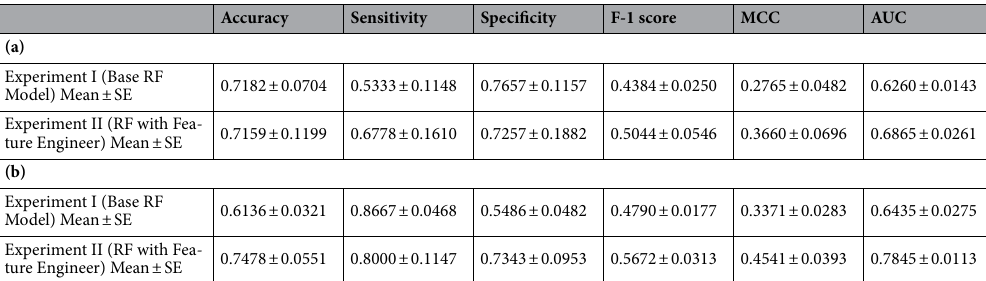
Table 2. (a) Experiment I, II comparison on linear gait variables and (b) Experiment I, II comparison on nonlinear gait variables.